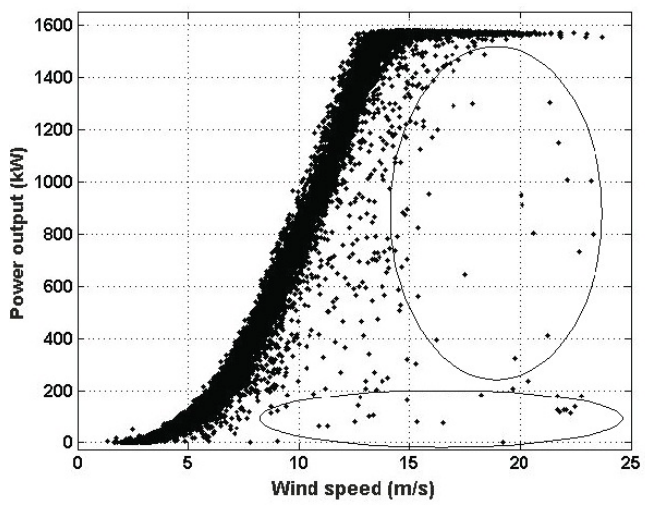
5 of 12 Figure 2. Annual average wind speed at 100 m AGL at the VWF in the year 2014. In this paper, in order to obtain the orographic map shown in Figure 1 and the annual average wind speed map shown in Figure 2, the Meteodyn WT wind resource assessment software was used [28–30]. Here, the input variables used were the following: topographic and roughness data of the VWF; wind speed data of the meteorological tower located in the VWF; guaranteed power curve of the WTs; air density of the VWF (0 . 923 kg/m 3 ); hub height of the WTs; wind turbine positions in UTM coordinates; and meteorological tower position in UTM coordinates. As was previously mentioned, the time measurement interval was from 1 October 2014 to 31